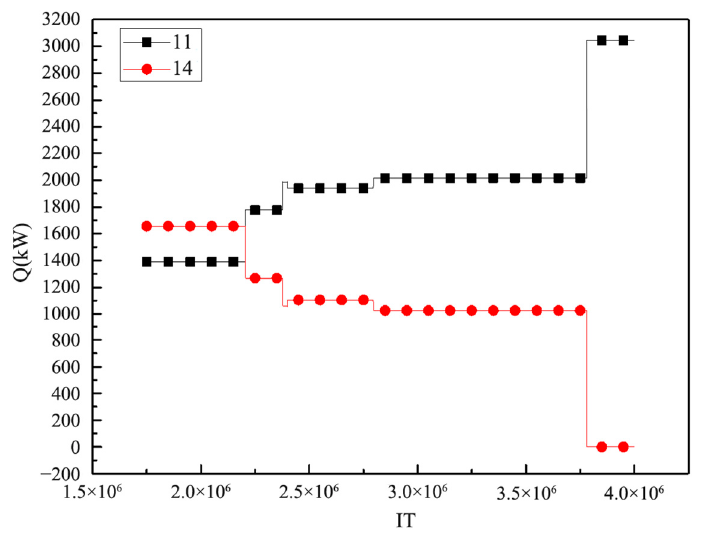
Figure 8. Heat load change of the heat exchanger on the stream without a utility exchanger.